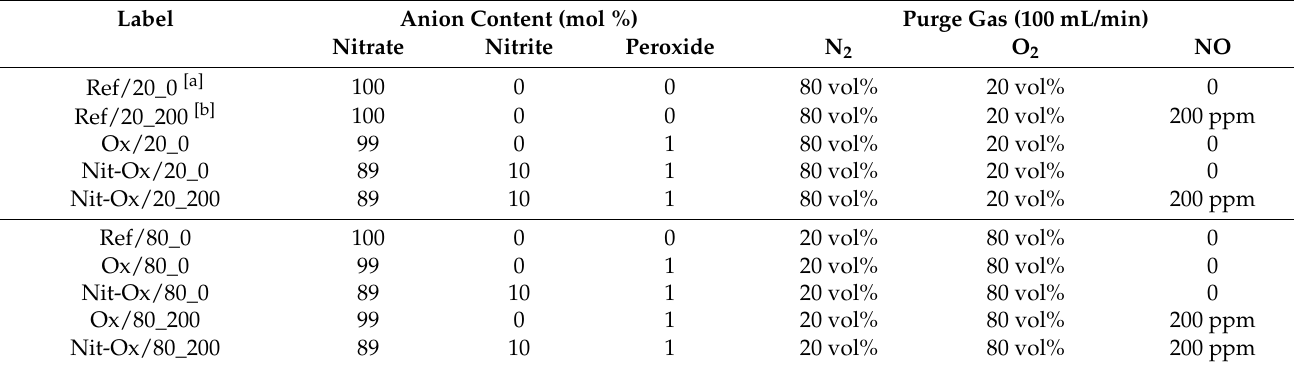
Table 1. List of experiments of this work (and literature). Labels are specified with regard to salt composition and purge gas composition. All salts exhibit Na/K ratios equal to that of ideal Solar Salt mixture (Na 65.5 mol %:K 35.5 mol %). Label